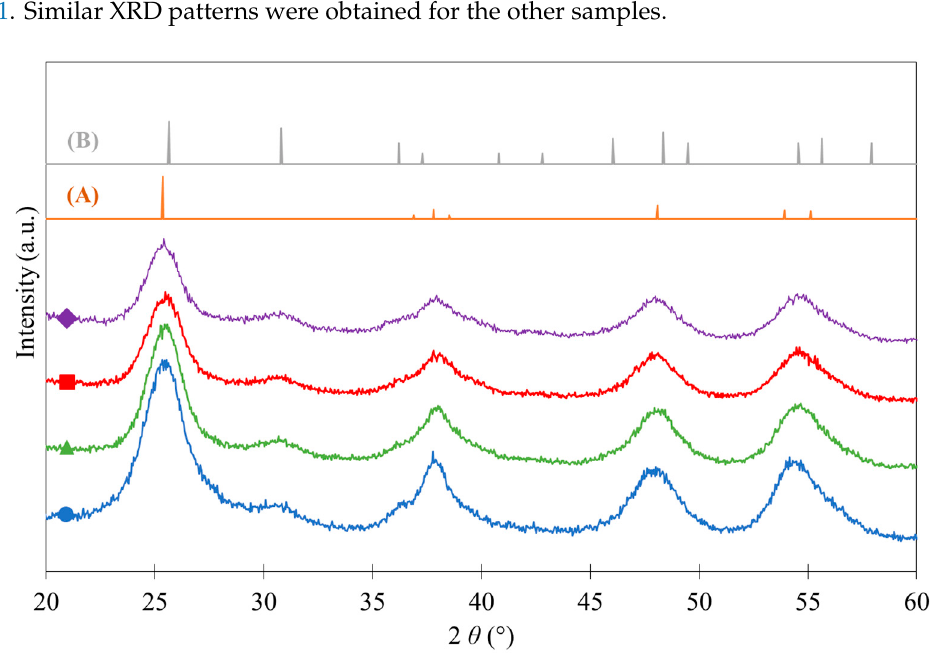
Figure 1. X-ray diffraction (XRD) patterns: ( ● ) pure TiO 2 , ( ▲ ) TiO 2 /Fe0.5, ( ■ ) TiO 2 /N43 and ( ♦ ) TiO 2 / Fe0.5 / N43. (A) Reference pattern of anatase and (B) reference pattern of brookite. Sample names and compositions are listed in Table 1.